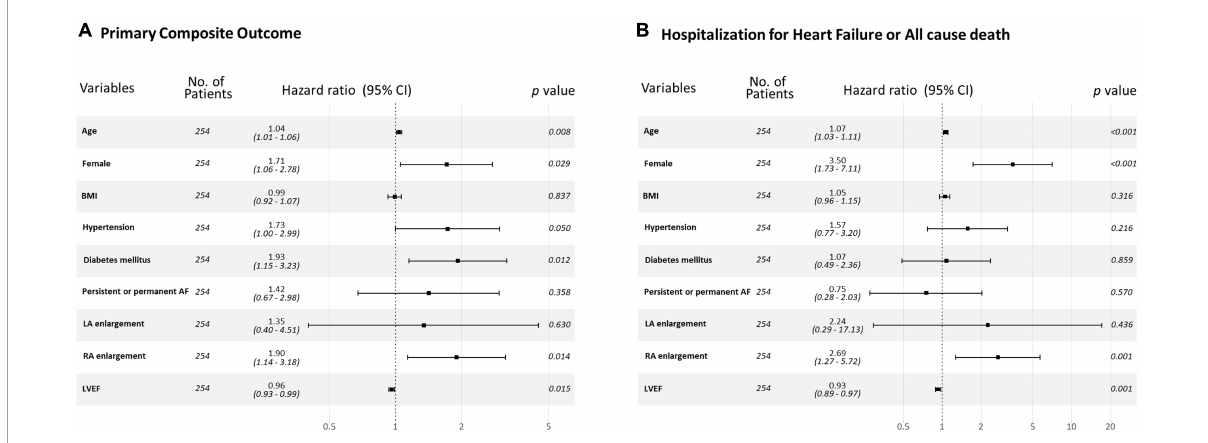
FIGURE3 Forest plot for (A) primary composite outcome and (B) a composite of HHF or all cause death for each variable. HHF, hospitalization for heart